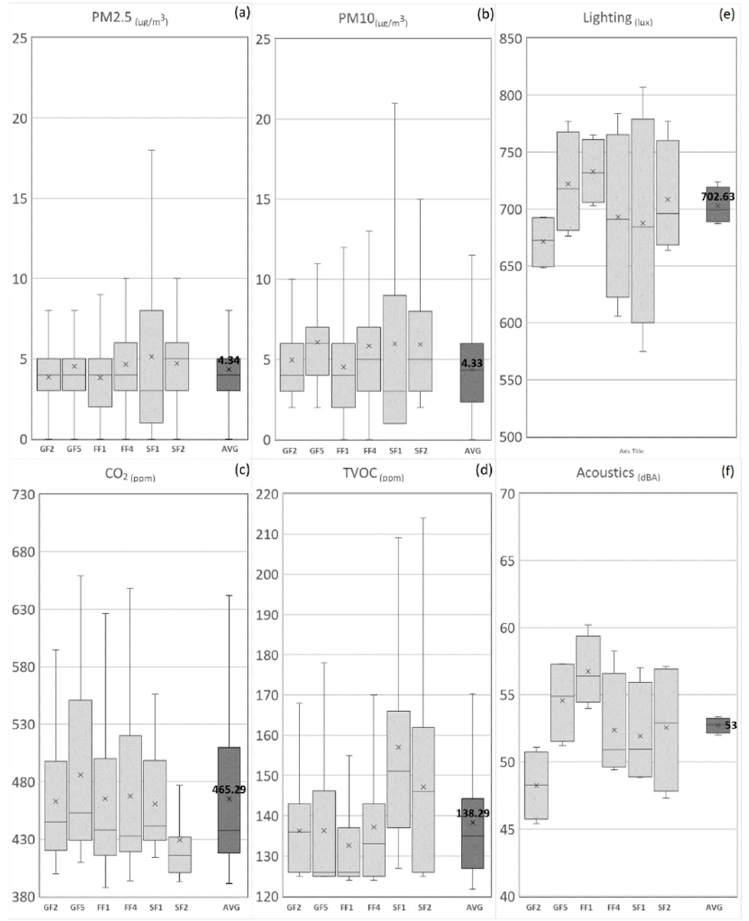
Figure 6. Distribution of environmental parameters obtained from spot measurements during December to February (dark grey box indicates total readings’ average) (numbers indicated are mean values).